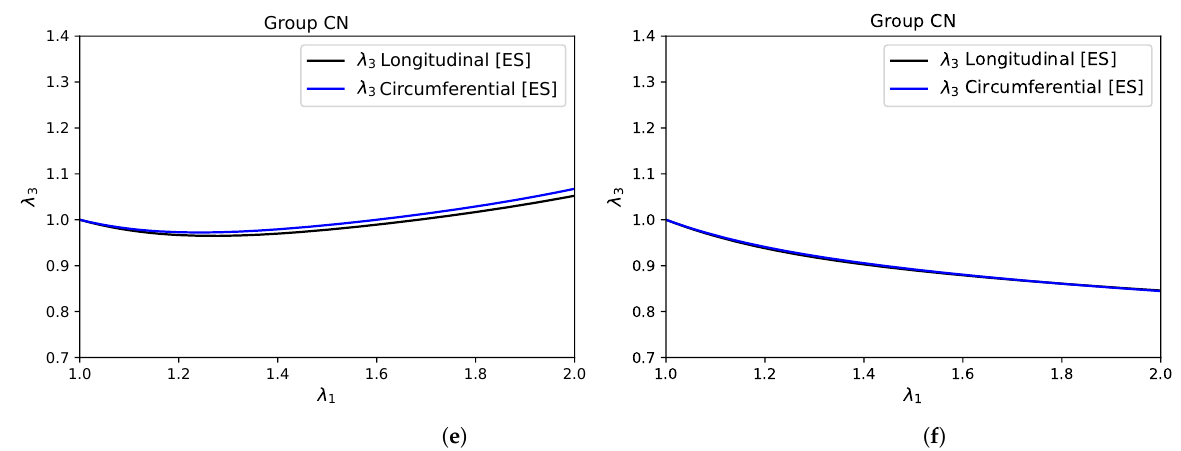
Figure 12. CN group adjustments. On the left are the results of the non-stabilized characterization and on the right the characterization with the stability term. ( a ) Pressurization; ( b ) Pressurization; ( c ) Tensile Test; ( d ) Tensile Test; ( e ) Transversal Stretch; ( f ) Transversal